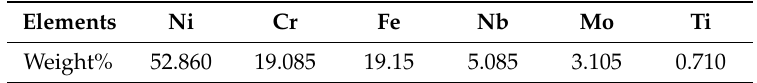
Table 1. The chemical composition of Inconel